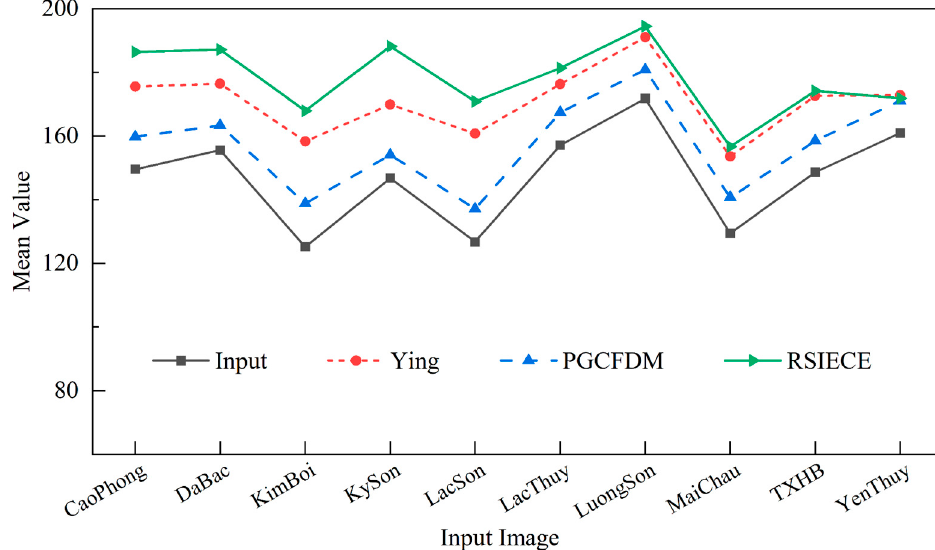
Figure 4. Comparison of the quality of the enhanced images by the RSIECE algorithm with that of the Ying and PGCFDM methods in terms of the mean criteria.